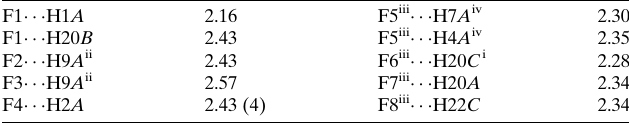
Table 1 Intermolecular H (cid:2)(cid:2)(cid:2) F distances (A˚ ) between all eight fluorine atoms of the two BF 4 (cid:4)